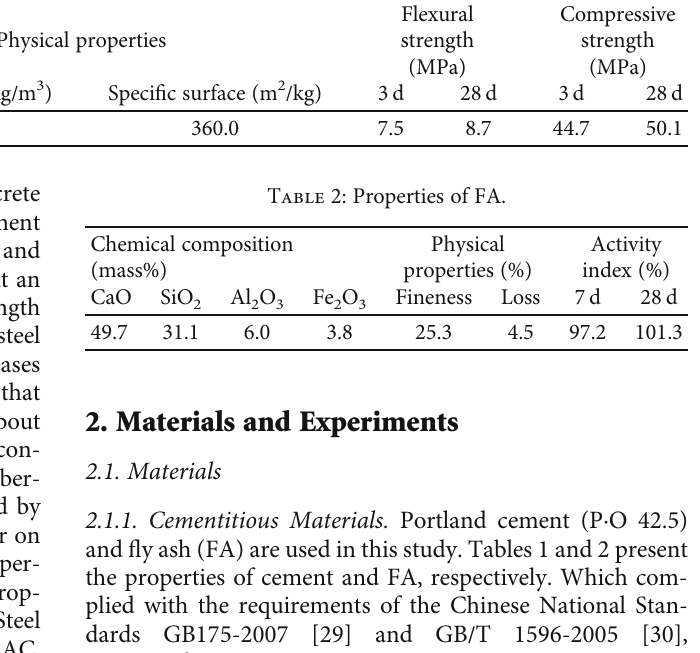
Table 1: Properties of cement.